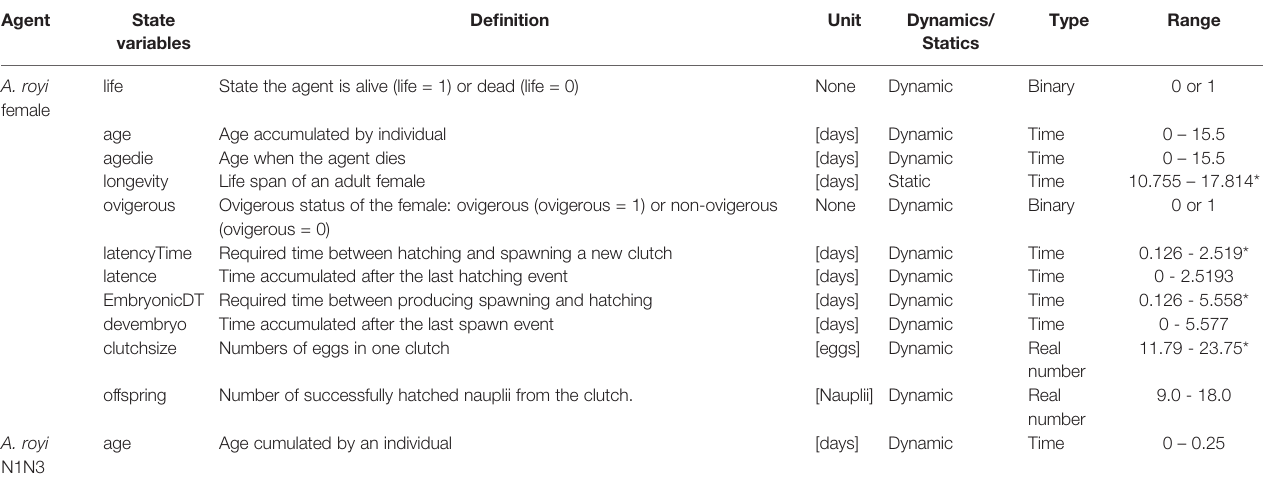
TABLE 1 | State variables used to represent the located agent of Apocyclops royi adult female and A. royi fi rst naupliar stages (N1N3).